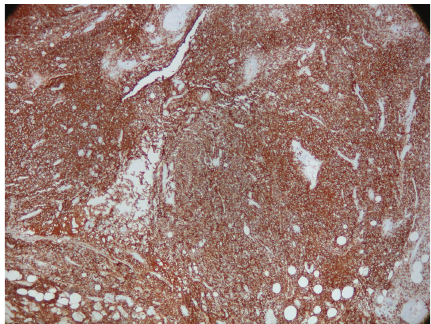
Figure 2: CD 20 immunostain showing 80–90% large lymphoid cells.